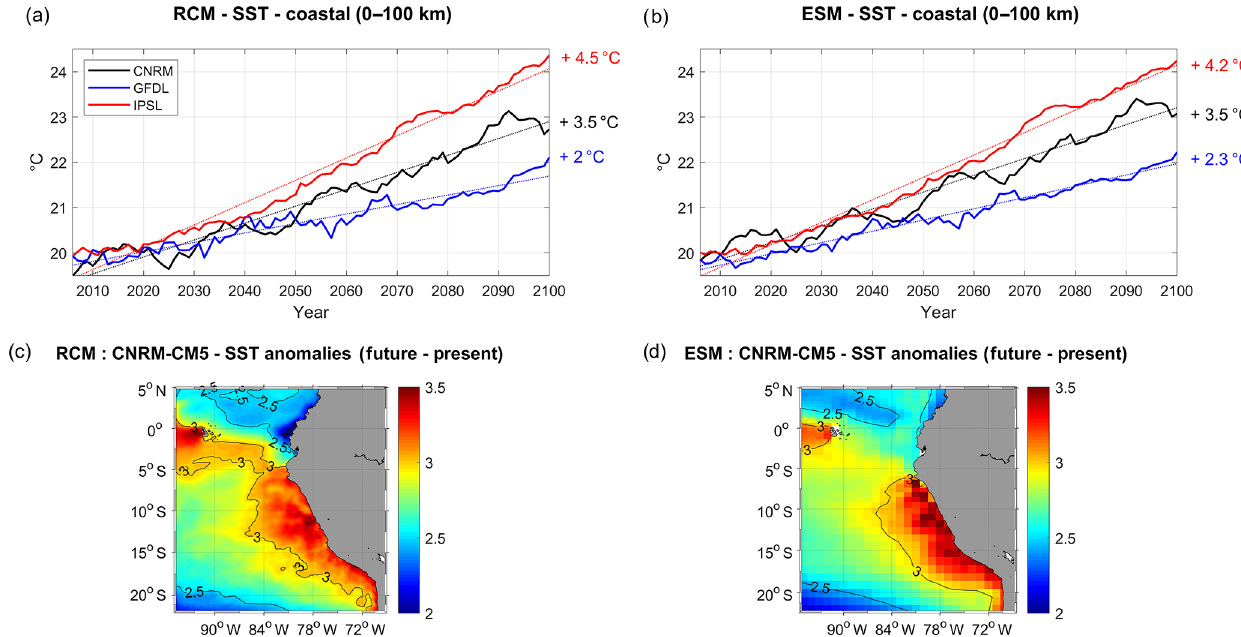
Figure 3. Coastal SST ( ◦ C) in (a) the RCMs and (b) the ESMs (CNRM in black, GFDL in blue, IPSL in red). All fields are averaged in a coastal box (see Fig. 2a), and annual mean time series are filtered using a 10-year moving average. SST biases are removed from ESM, to compare with RCM (respectively 5, 6, and 4.5 ◦ C for CNRM, GFDL, and IPSL). Dotted lines indicate linear trends and percentage values indicate the change between 2006 and 2100 with respect to the present conditions using the linear trend values (i.e., 100. ( X(t = 2100 ) − X(t = 2006 ))/X(t = 2006 ) , where X(t) is the linear trend). (c) R-CNRM SST anomaly (2091–2100 average minus 2006–2015) and (d) CNRM SST anomaly (2091–2100 average minus 2006–2015).